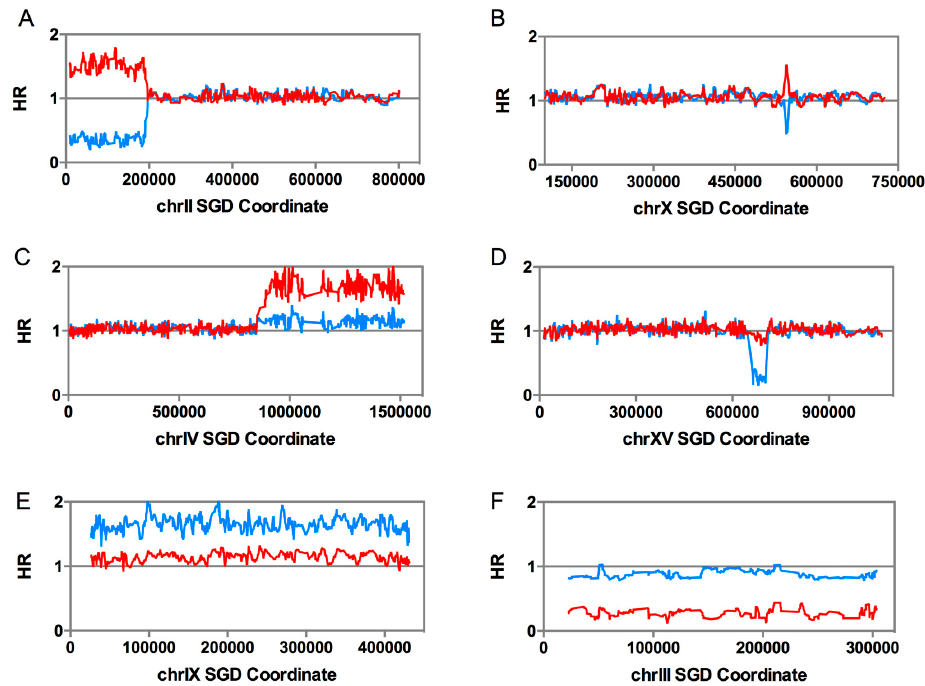
Figure 2. LOH events, large duplications/deletions, and ploidy alterations as detected by single-nucleotide polymorphism (SNP) microarrays. As described in the text, SNP-specific microarrays can be used to detect LOH events, as well as other types of chromosome alterations. In each panel, we show the level of hybridization of W303-1A-specific SNPs (red lines) and YJM789-specific SNPs (blue lines). These values are normalized to the level of hybridization observed in a heterozygous diploid. A hybridization ratio (HR) of 1 indicates heterozygosity, and values about 1.5 or 0.2 indicate 2-fold increases or decreases in hybridization of the SNPs, respectively. ( A ) Terminal LOH event. Such an event could be caused by either a crossover or break-induced replication (BIR) event. ( B ) Interstitial LOH event. These events reflect gene conversions. ( C ) Terminal duplication. A segment of the chromosome is duplicated. As described in the text, such events are usually observed in cells that also have a terminal deletion, and likely reflect a double-stranded DNA break (DSB) on one chromosome that is repaired by a BIR event involving a different homolog, resulting in a translocation. ( D ) Interstitial deletion. In this event, there was a deletion on the blue homolog. Such deletions usually involve homologous recombination between non-allelic repeats. ( E ) Trisomy. In this cell, the blue homolog is present in two copies, and the red homolog in one copy. ( F ) Monosomy. In this cell, the red homolog was lost, and the blue homolog retained. SGD: Saccharomyces Genome Database.